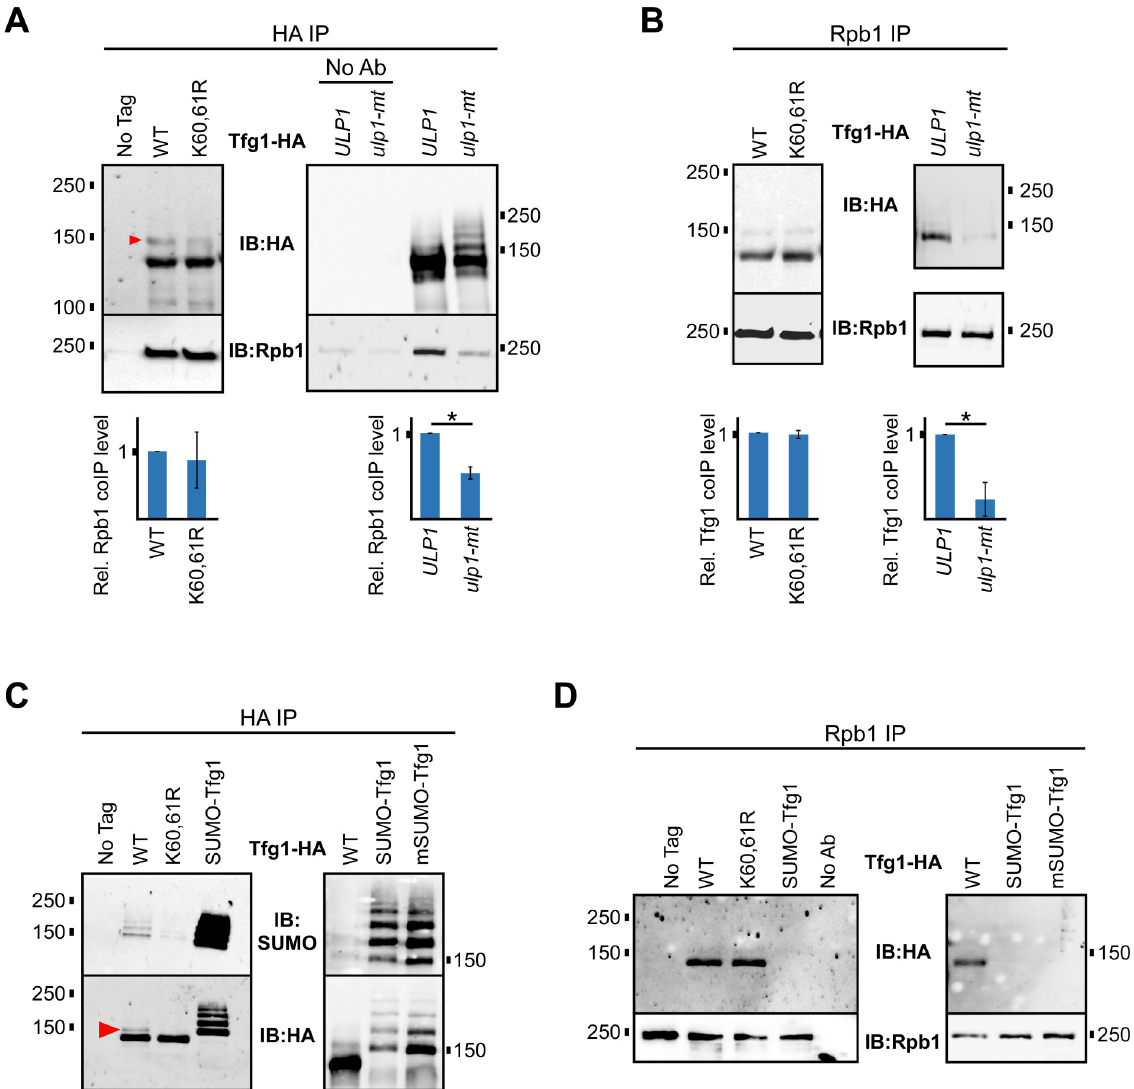
Fig 5. Elevated Tfg1 sumoylation reduces its interaction with RNAPII. (A) Tfg1-HA and Tfg1-K60,61R-HA strains, and strains expressing Tfg1-HA in the ulp1-mt (I615N) or ULP1 parental backgrounds, were used for co-IP experiments. HA IPs, and no antibody (No Ab) controls, were analyzed by HA and Rpb1 (8WG16 antibody) immunoblots. Relative levels of co-IPed Rpb1, normalized to Tfg1-HA IP levels, were determined by densitometry and average values from at least three experiments are shown. Student’s t -tests were performed and paired values that are statistically different ( p value < 0.05) are indicated with an asterisk. (B) Using the same strains described in A , Rpb1 IP was performed, followed by HA and Rpb1 immunoblots. Quantification of levels of co-IPed Tfg1-HA, normalized to IPed Rpb1 levels, was performed as in A . (C) Strains expressing Tfg1-HA with an N-terminal fusion to the yeast SUMO peptide (SUMO-Tfg1) or to a mutant form of the SUMO peptide in which all Lys residues are replaced with Ala (mSUMO-Tfg1), were analyzed alongside strains expressing WT and K60,61R forms of Tfg1-HA in a HA IPs, followed by SUMO and HA immunoblots. (D) Strains expressing WT, K60,61R, SUMO-Tfg1, or mSUMO-Tfg1 forms of Tfg1-HA were used for Rpb1 IP followed by immunoblot analysis with HA and Rpb1